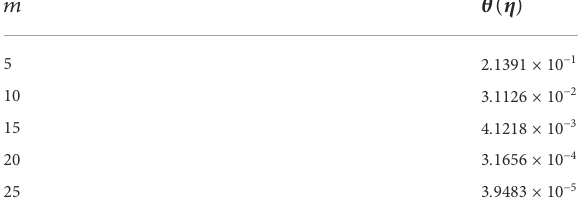
TABLE 3 Convergence of the de fi ned problem for the temperature equation; from table 3, we see that as we increase the number of iteration, the residual error decreases and strong convergence is obtained.